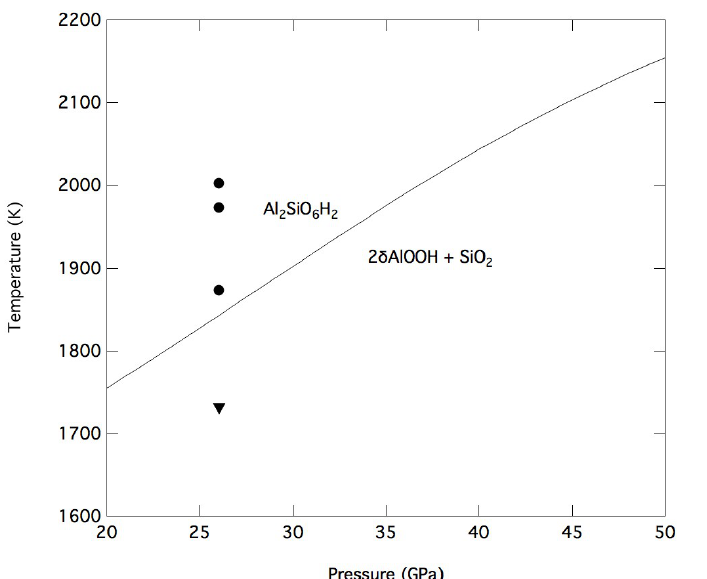
Figure 6. The calculated phase boundary of aluminous phase D and 2 δ -AlOOH+SiO 2 as a function of temperature and pressure assuming random distribution of Al and Si across the occupied octahedral sites in MgSi 2 O 6 H 2 (dashed) and a random distribution of Al and Si across all possible octahedral sites (solid). Predicted phase boundaries are compared to synthesis data of phase D (circle) and mixtures of 2 δ -AlOOH+SiO 2 (triangle) from [15]. Calculations are in a water-free system that does not capture effects of breakdown to constituent